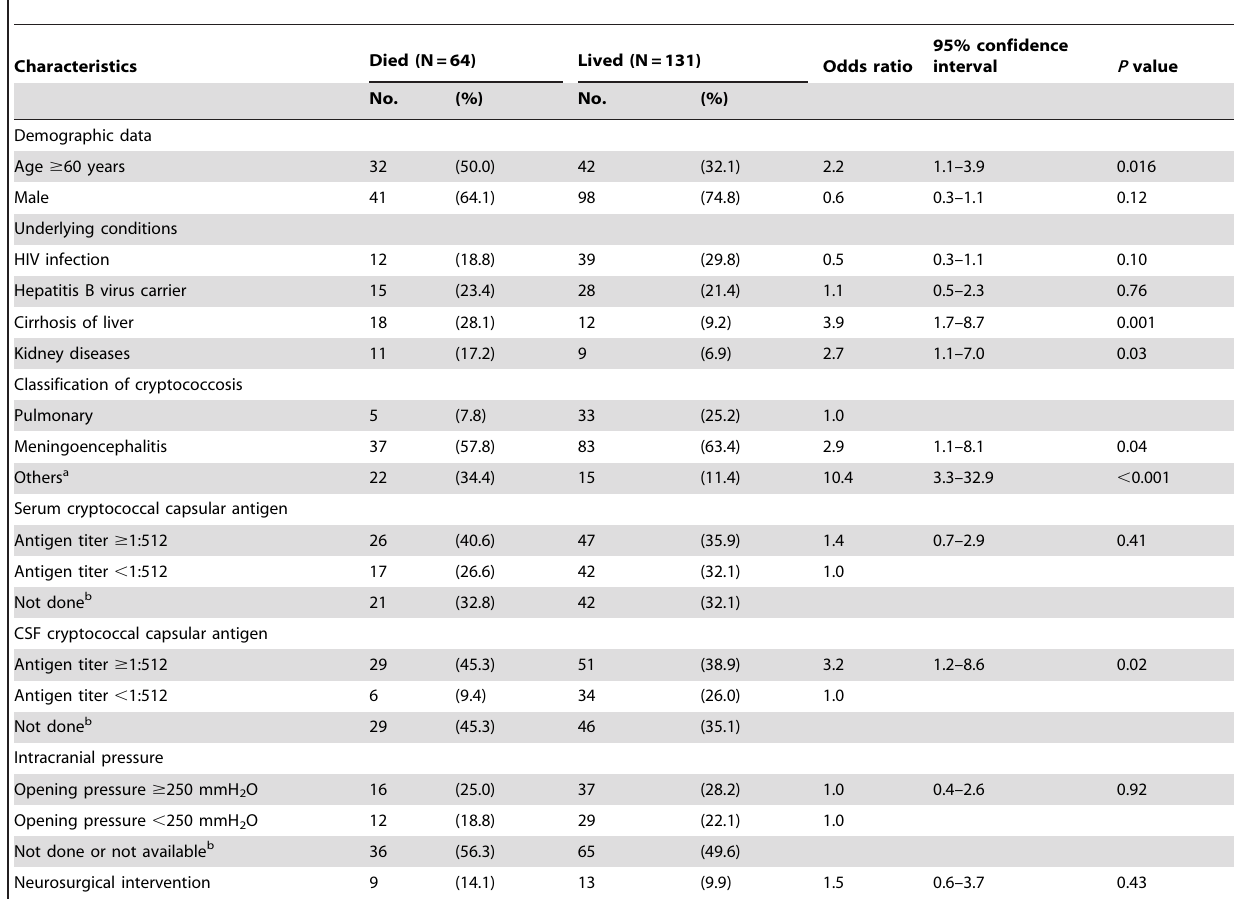
Table 4. Risk factors associated with 10-week mortality for 195 patients with cryptococcosis in Taiwan.